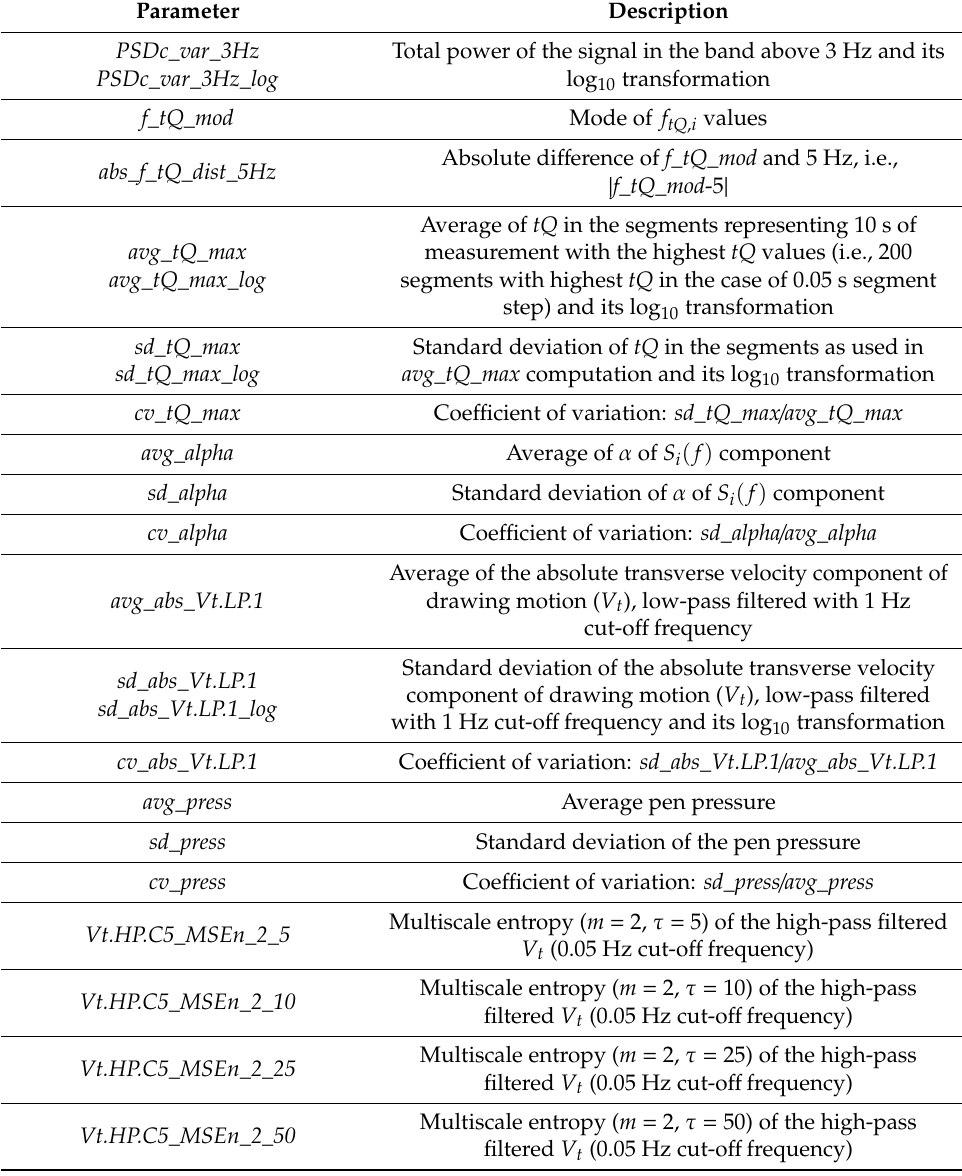
Table 1. Parameters computed from the time